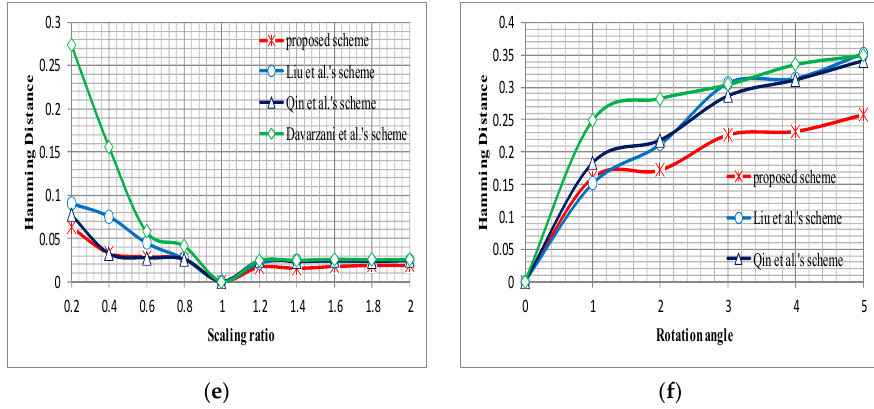
Figure 3. The robustness comparison in terms of the average normalized Hamming distance. ( a ) JPEG compression; ( b ) Gaussian filtering; ( c ) median filtering; ( d ) Salt & pepper noise; ( e ) Scaling, and ( f ) Rotation.